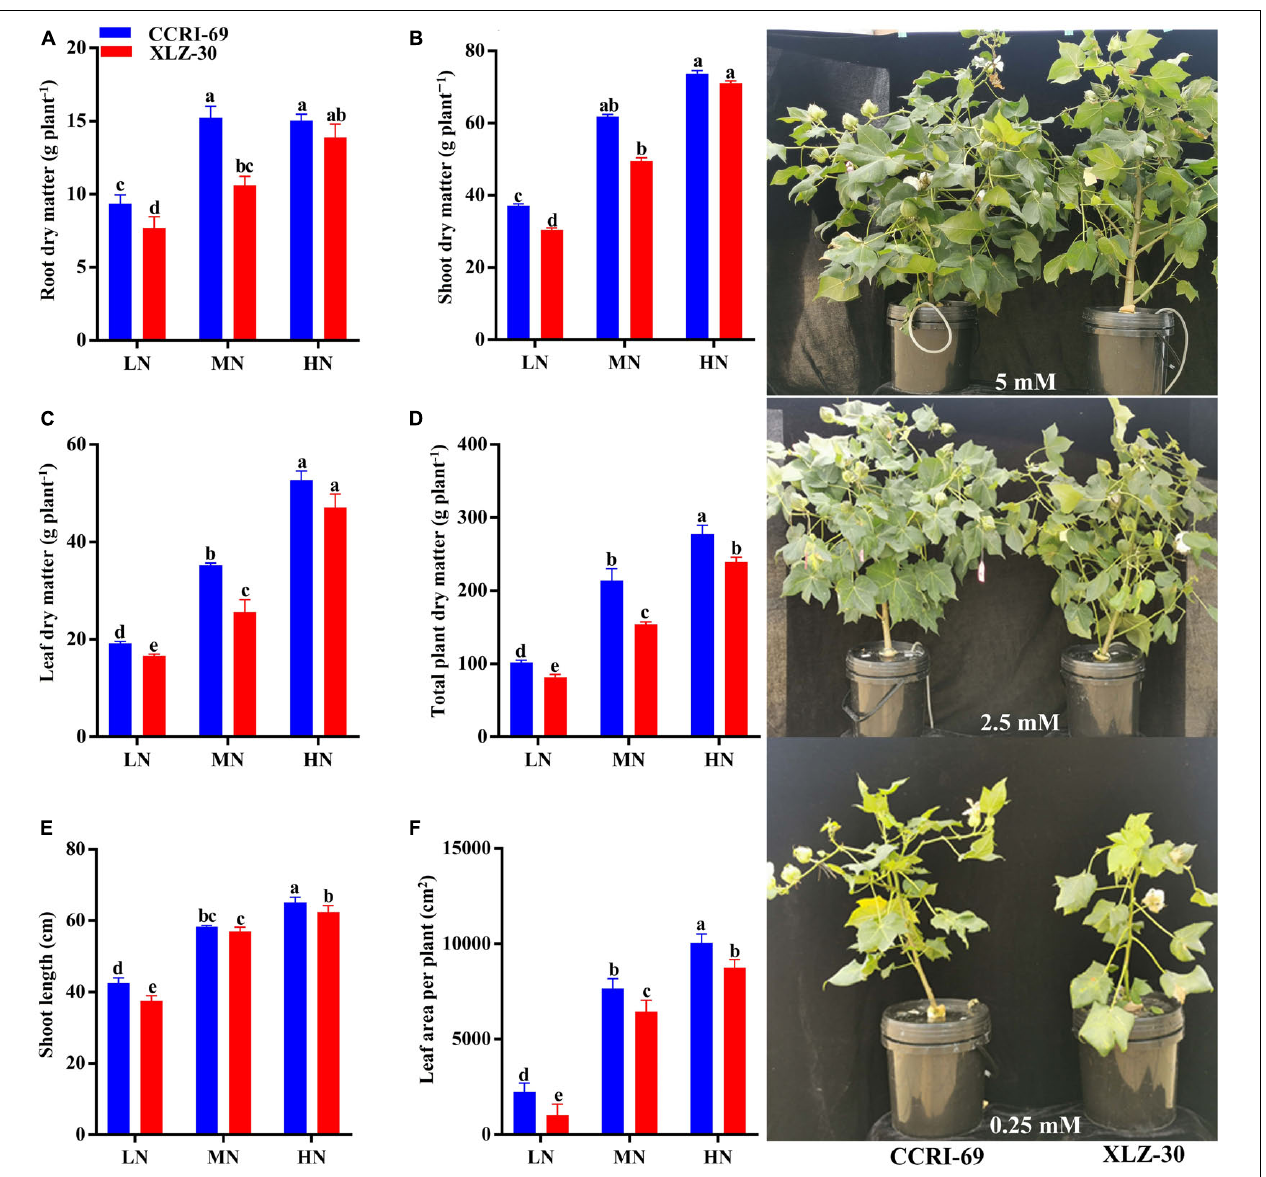
FIGURE 1 | (A–F) Root dry matter (g plant − 1 ), shoot dry matter (g plant − 1 ), leaf dry matter (g plant − 1 ), total plant dry matter (g plant − 1 ), shoot length (cm), and leaf area per plant (cm 2 ), and plant phenotypes of CCRI-69 and XLZ-30 in response to low (LN; 0.25 mM), moderate (MN; 2.5 mM), and high (HN; 5 mM) N levels. Error bars with different small letters show significant differences between genotypes under different N levels ( p <